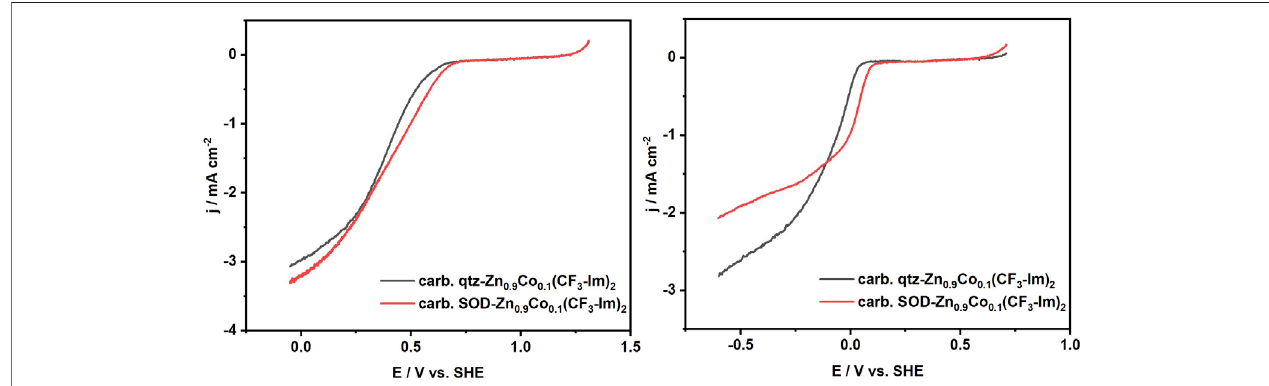
FIGURE 10 | Electrochemical characterization of qtz-Zn 0.9 Co 0.1 (CF 3 -Im) 2 and SOD-Zn 0.9 Co 0.1 (CF 3 -Im) 2 immobilized on a RDE (1,600 rpm) by linear sweep voltammetry in